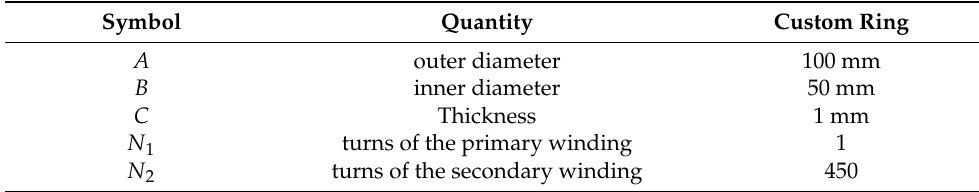
Table 2. Parameters of the tested custom ring specimen. Symbol Quantity Custom